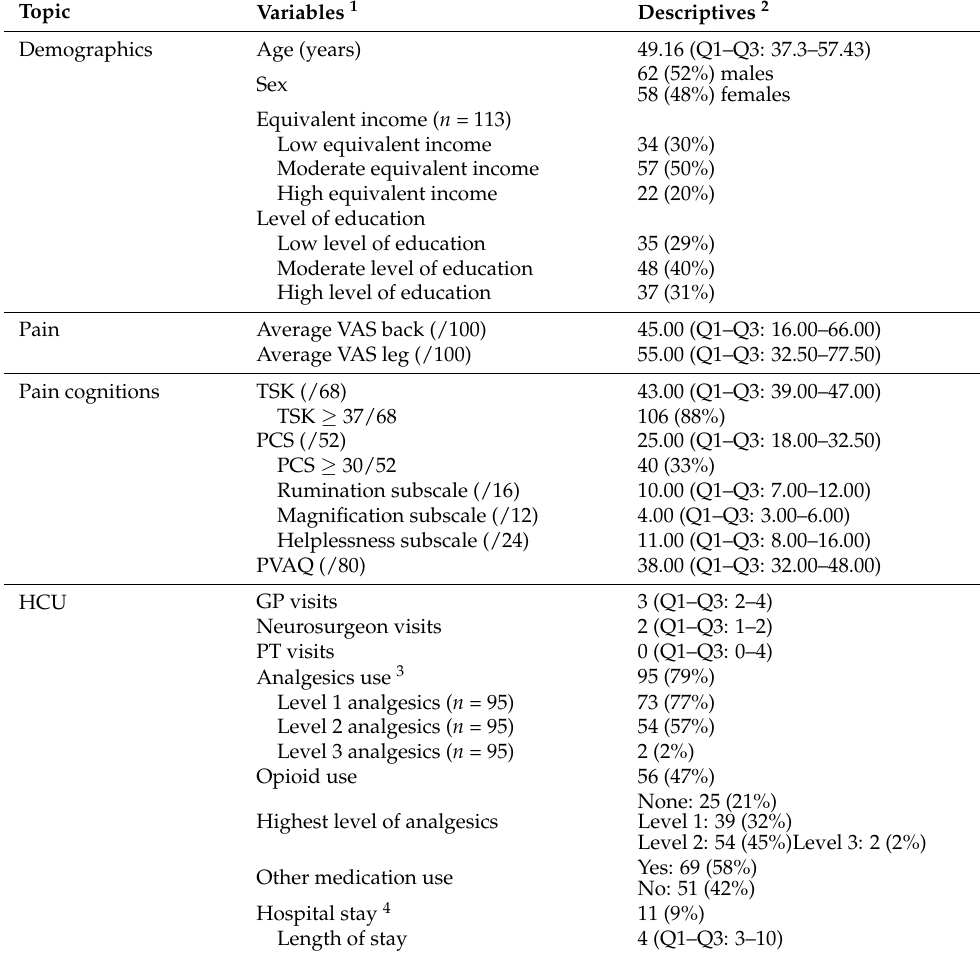
Table 1. Descriptives of demographics, pain intensity, pain cognitions and healthcare use during the past 2 months in people undergoing surgery for lumbar radiculopathy ( n =